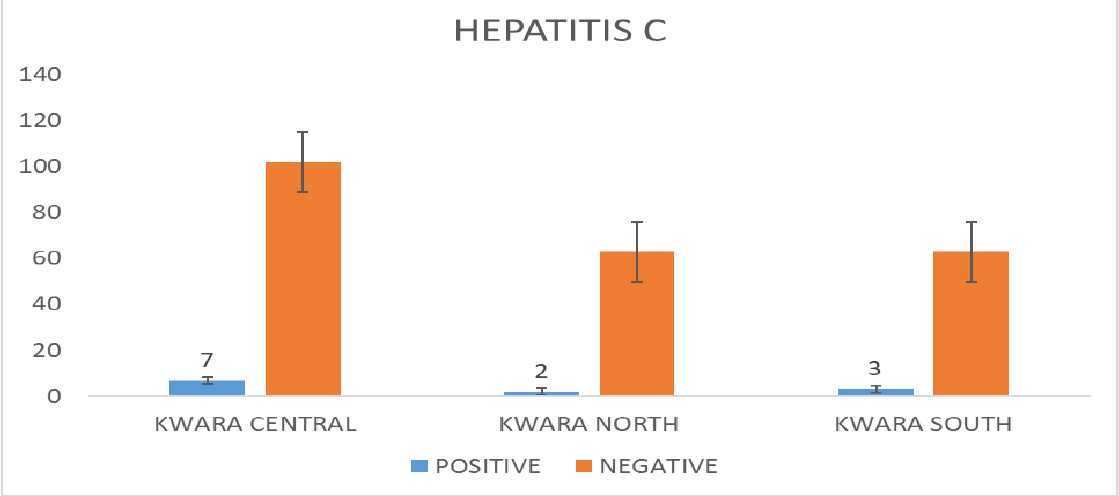
Figure 3. Hepatitis C incidences among scavenger across the three senatorial districts.